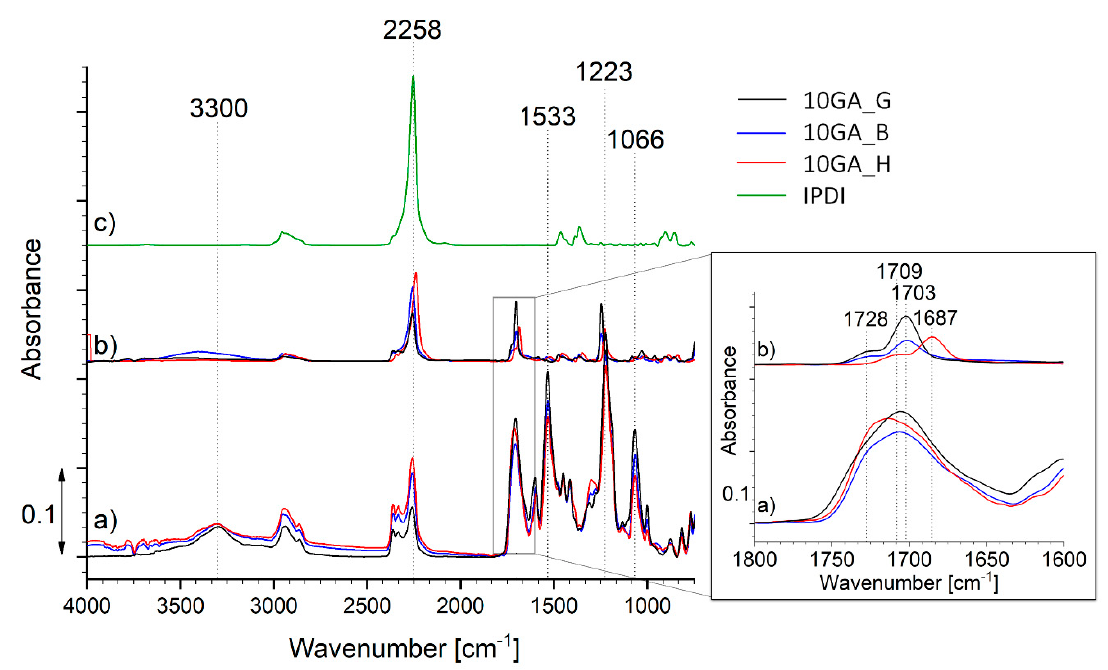
Figure 8. FTIR spectra of the crushed microcapsules 10GA_G, 10GA_B and 10GA_H ( spectrum a ), filtered core material ( spectrum b ), and pure IPDI ( spectrum c ).